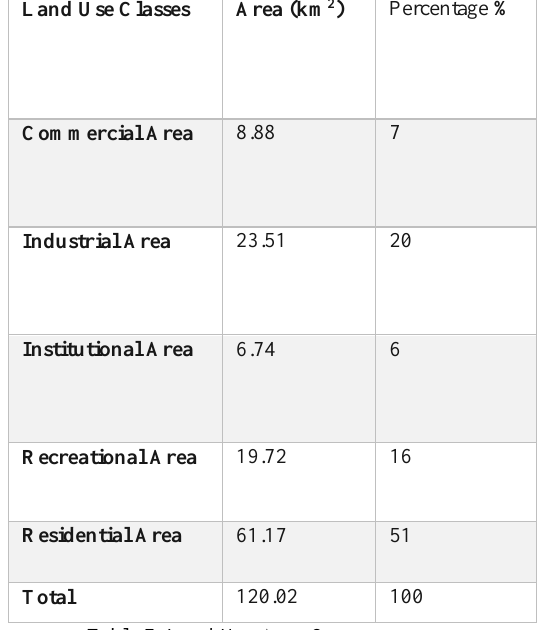
Table 7: Land-Use Area Coverage